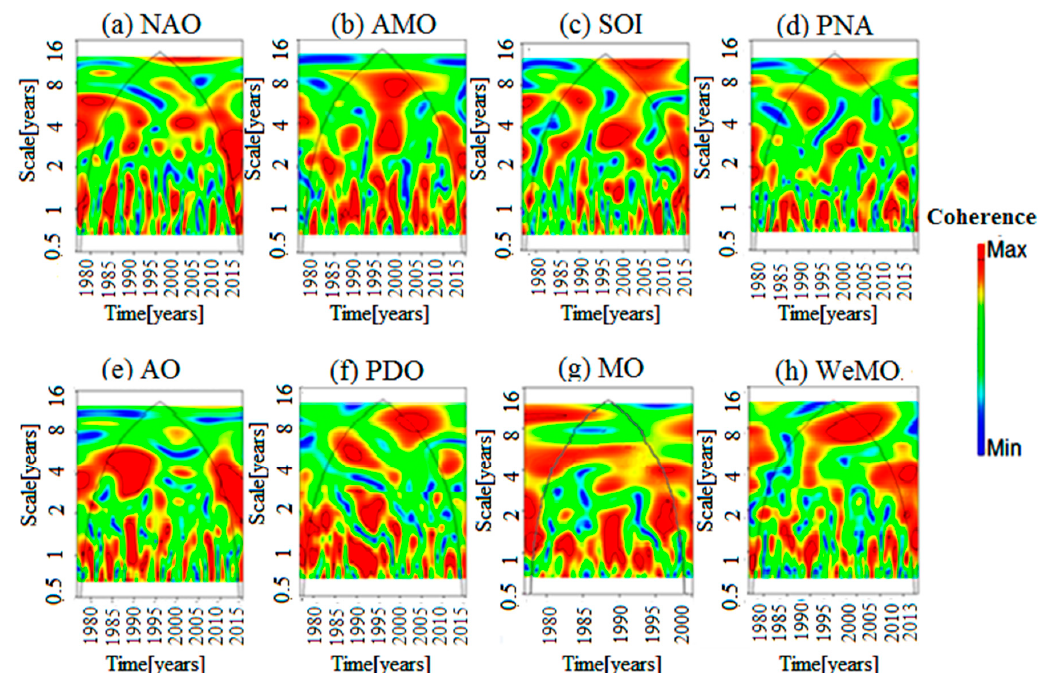
Figure 8. Spectrum of Wavelet coherence for climate indices and precipitation in station 4. ( a ) NAO: North Atlantic Oscillation, ( b ) AMO: Atlantic Multidecadal Oscillation, ( c ) SOI: Southern Oscillation Index, ( d ) PNA: Pacific–North-America teleconnection, ( e ) AO: Arctic Oscillation, ( f ) PDO: Pacific Decadal Oscillation, ( g ) MO: Mediterranean Oscillation, ( h) WeMO: West Mediterranean Oscillation.